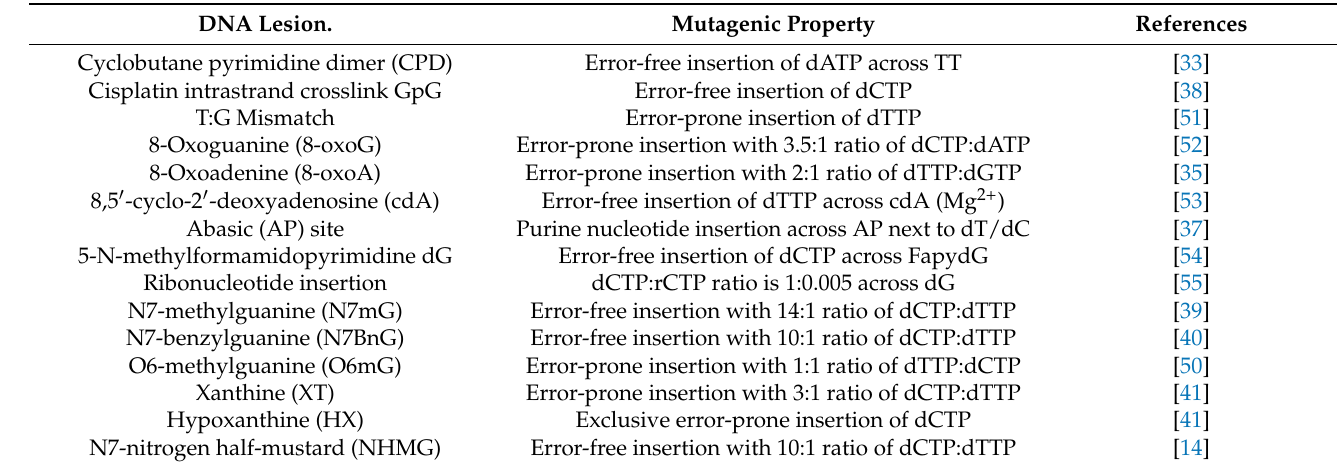
Table 1. Representative DNA lesions bypassed by pol η